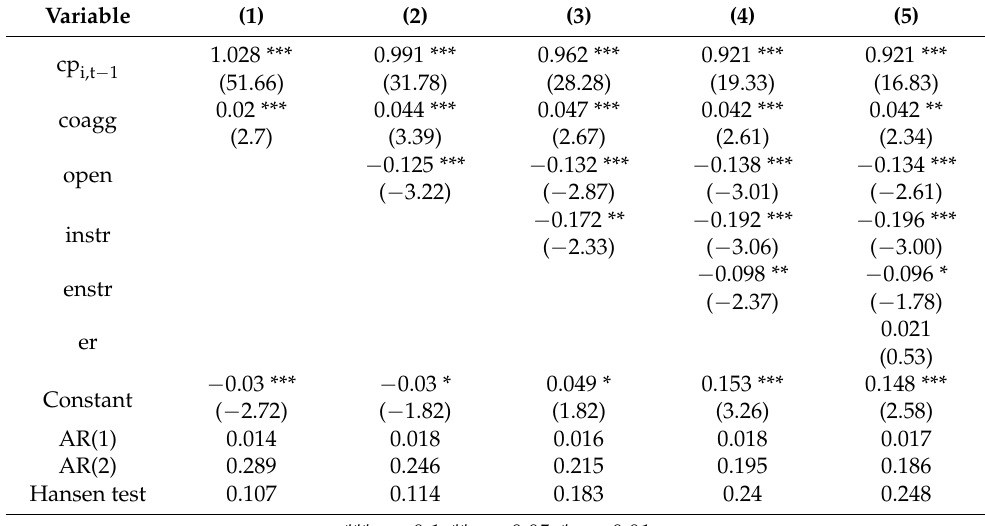
Table 2. Results of benchmark regression.